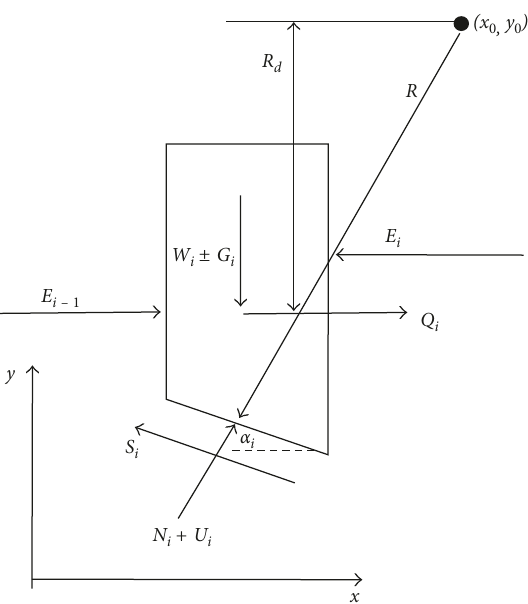
Figure 1: Distribution of vertical acceleration within the flexible sliding body.